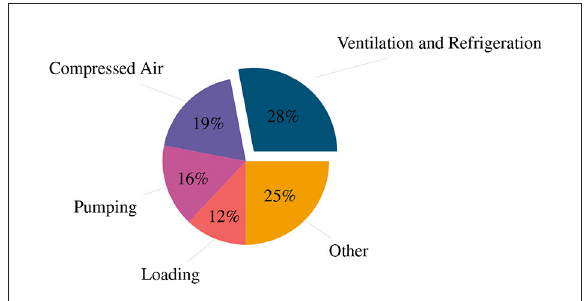
FIGURE1 Energy distribution of a typical deep-level